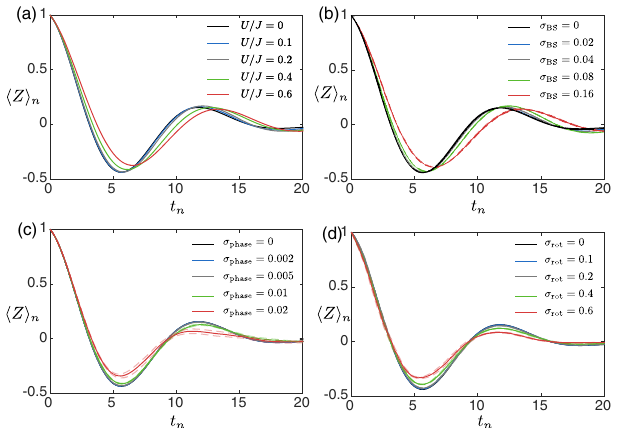
FIG. 5. Effects of imperfect implementations of the individual operations on the Ramsey signal, for the same system parameters as in Figs. 3 and 4 (with N ¼ 4 sites in each copy). We separately show the effects of (a) residual interactions in the beam-splitter steps, (b) uncertainty of the tunnel times in the beam-splitter steps, (c) fluctuations in the phase acquired during the controlled phase gates, and (d) fluctuations in the rotation angle for single- qubit rotations (see text). For (b) and (c), we perform an average over different error realizations. The statistical uncertainties are indicated by the dashed lines. The size of the stroboscopic time step is ϵ ¼ 0 . 07 in all